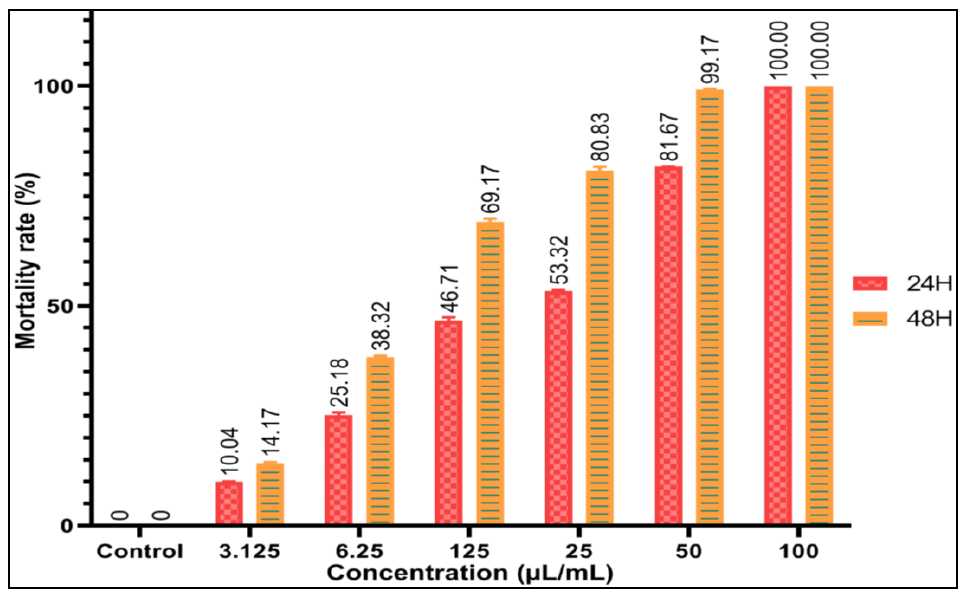
Figure 5. Mortality rate of adults of C. capitata at different concentrations of EO of O. elongatum after 24 and 48 h of exposure (The results are significantly different ( p < 0.0001) . Table 5. DL 50 of the EO of O. elongatum against the adults of C. capitata .